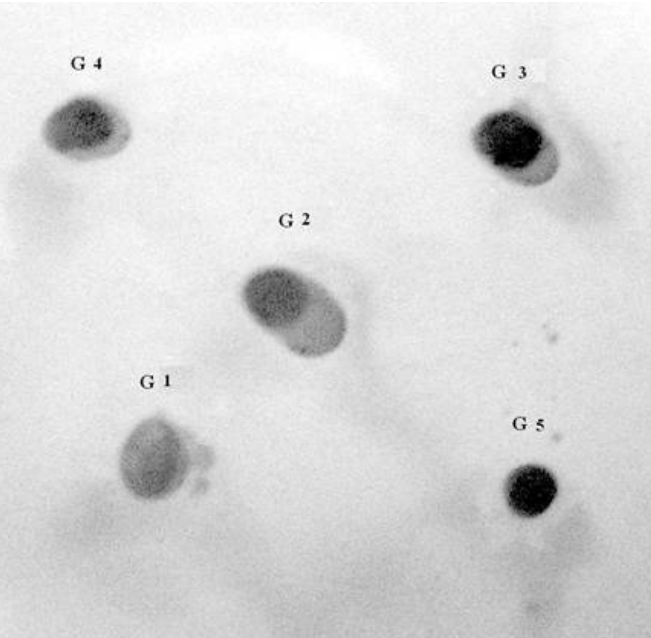
FIGURE 1 - Scanned image of a polyvinylidene difluoride (PVDF) membranes recording the immunoblotting of protein carbonyl detected in intestinal plasma samples in the five experimental groups. Group 1 (G 1) - Control; Group 2 (G 2) - Sham laparotomy with Propofol; Group 3 (G 3) - Ischemia/Reperfusion (I/R) with Propofol; Group 4 (G 4) - I/R with Propofol and N-Acetylcysteine (NAC); Group 5 (G 5) - I/R with Ketamine and Xylazine